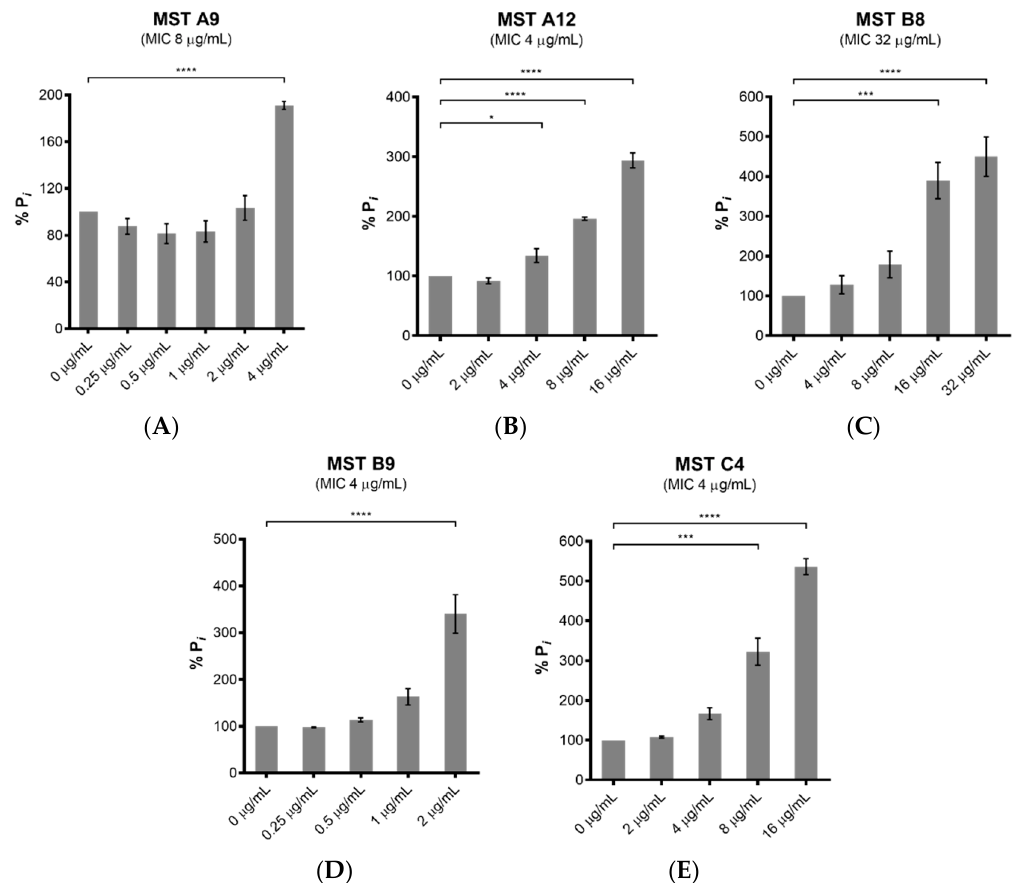
Figure 5. The MST compounds stimulate GTPase activity in a dose-dependent manner. The GTPase activity of purified SaFtsZ (23.6 nmol) was determined from the liberation of P i from GTP using malachite green. SaFtsZ was incubated with five of the MST compounds as indicated ( A – E ) for 30 min before the reaction was initiated by addition of 1 mM GTP and the reaction terminated by the addition of citric acid after 10 min. The P i release rate was normalized relative to the sample without the addition of MST compounds (0.514 mM Pi / mg SaFtsZ / min) that was taken as 100%. The results are presented as the mean ± SEM. Statistical analysis was performed using one-way ANOVA and statistical significance was represented with asterisks (*) as shown in the Figure (* p < 0.05; *** p < 0.005; **** p < 0.001).